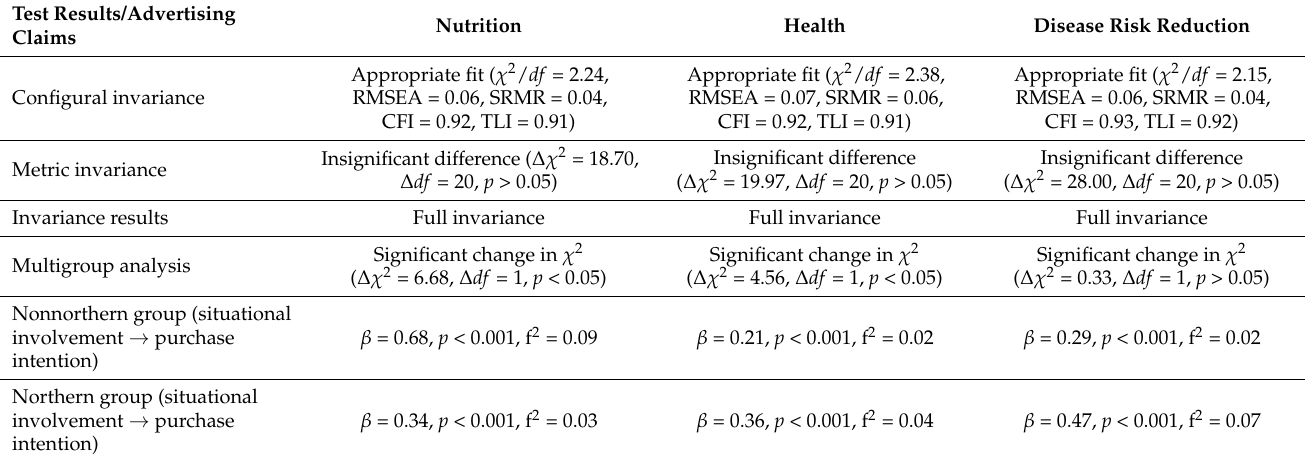
Table 4. Comparative results of residential regions under the same advertising claim ( n =